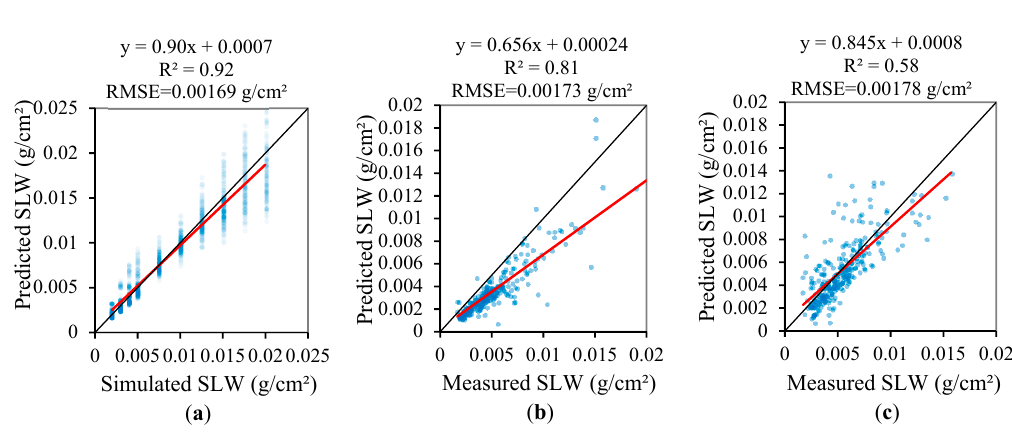
Figure 7. The results of the validation of the specific leaf weight (SLW) model based on the principal component analysis (PCA) method obtained using the simulated ( a ), ANGERS ( b ) and LOPEX’93 datasets ( c ). RMSE is the root mean squared error computed based on the SLW model as in Equation (6); R 2 is the determination coefficient.